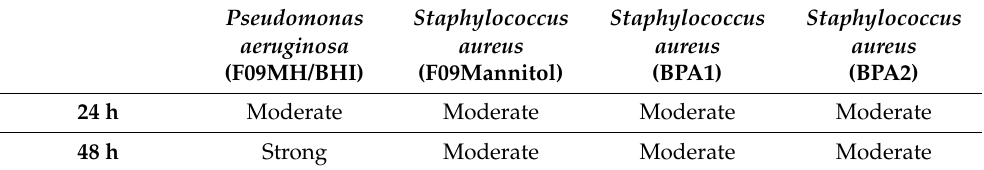
Figure 1. Values of optical density at 570 nm (OD 570nm ) as a measure of biomass of 24 h and 48 h old biofilms. The mean ± standard deviation of three independent experiments is illustrated. * p < 0.05. Table 2. Biofilm formation classification according to Stepanovi´c et al. [17]. For moderate biofilm producers: 2 × ODc < OD ≤ 4 × ODc; for strong biofilm producers: OD > 4 × ODc. The considered ODc value was 0.193 ± 0.030.